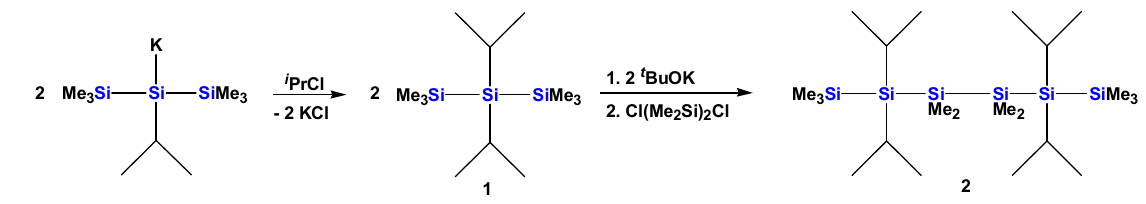
Scheme 1. Synthesis of a hexasilane with bulky isopropyl groups in the 2- and 5-positions.